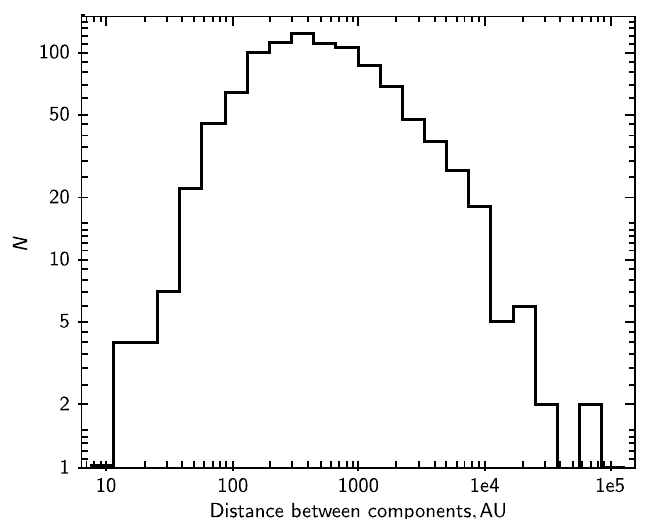
Fig. 7. Distribution of the distance between the components for the restricted sample of 998 visual binaries. The dataset is still not free of selection effects and cannot be viewed as representative of the initial or present-day distribution of binary